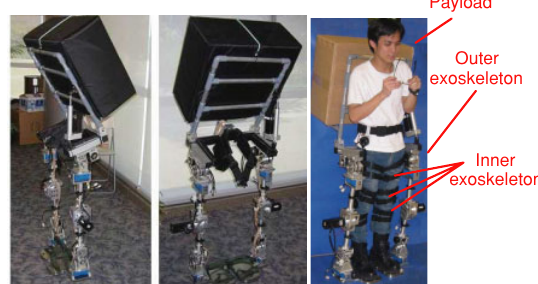
Figure 20 A user resting with the integrated exoskeleton system.